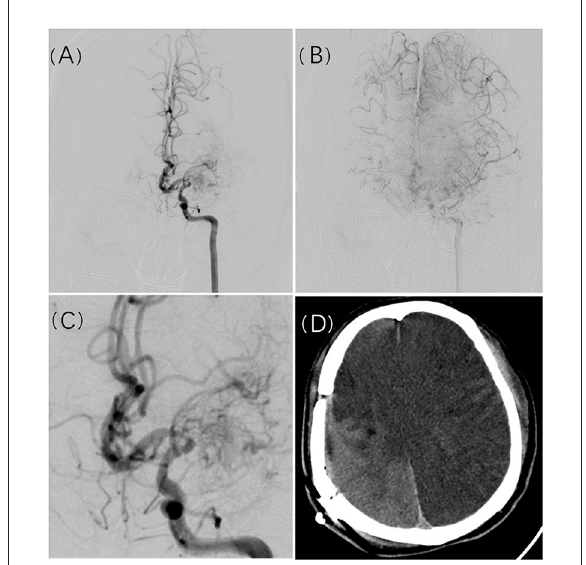
FIGURE1 A 49-year-old man presented with recurrent slurred speech and numbness of the left limbs. Cerebral angiogram revealed left MCA occlusion with compensation to the right ACA territory (A,B) . Manification of the L ICA angiogram showed severe stenosis of A1 (C) . Postoperative massive cerebral infarction occurred in the bilateral hemisphere approximately 3 days after surgical revascularization (D)